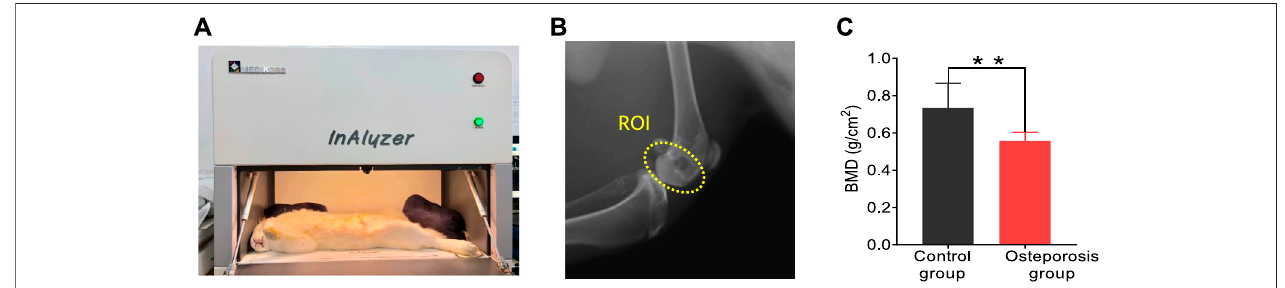
FIGURE 2 | DEXA images results. (A) Commercial DEXA imaging system. (B) DEXA images showing the regions of interests (ROI). (C) DEXA imaging at the ROI demonstrates signi fi cantly reduced BMD in the osteoporosis group vs. control group. ** stands for p < 0.01 in unpaired t -test comparing the results from the two bone groups (N (cid:1) 8 for osteoporosis group, N (cid:1) 8 for control